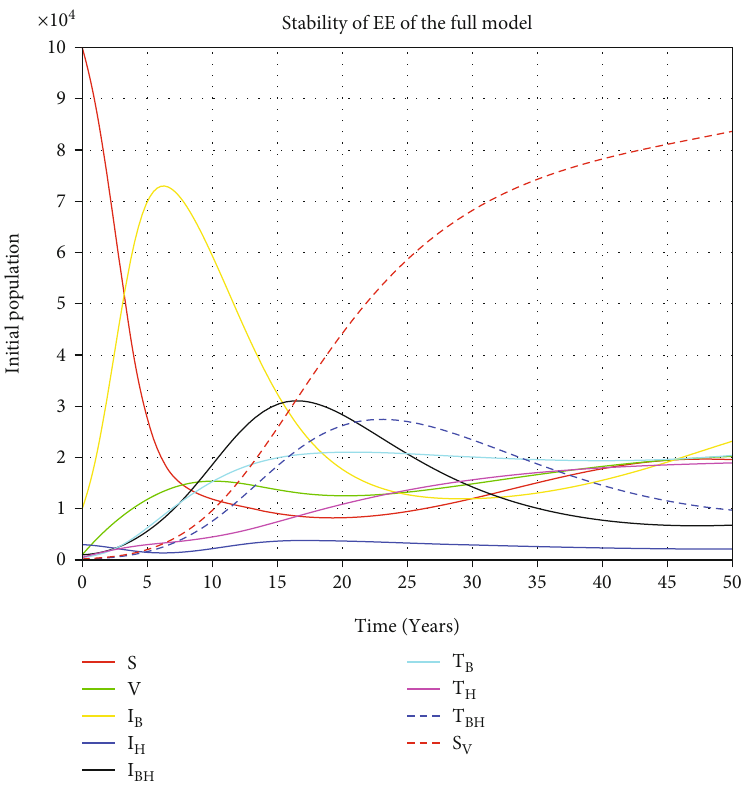
= 6 : 8 , ω = 0 : 9 , ω = 0 : 5 , and α = 0 : 03 . B H eff